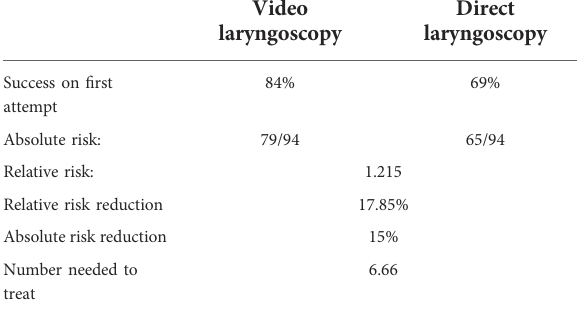
TABLE 3 Success rate of the fi rst attempt of